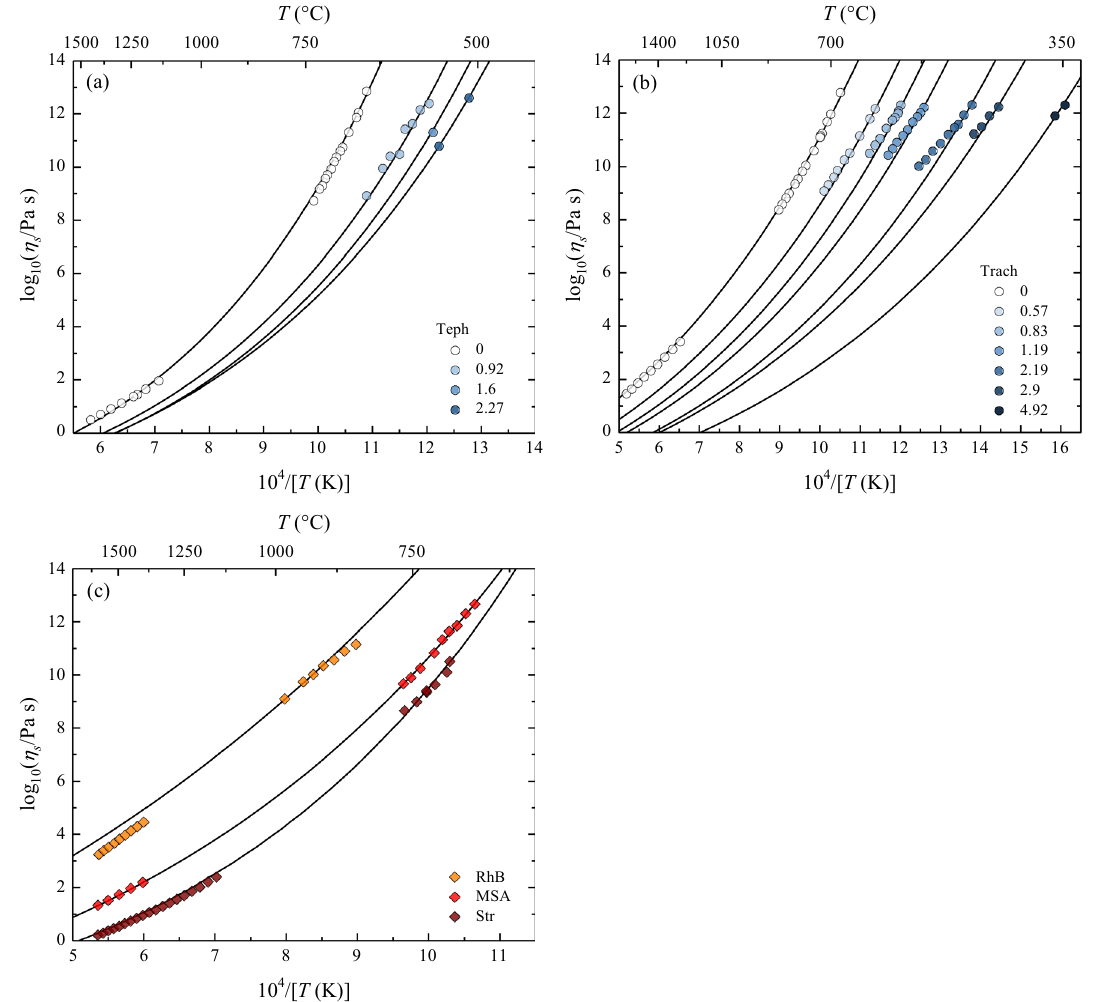
Figure 4. External predictions of anhydrous and hydrous viscosity. ( a ) Measured (symbols) anhydrous and hydrous viscosity data for tephrite (Teph) 61 and predictions (lines) using Brillouin velocities (Table 2). Numbers in the legend indicate the water content of samples in wt%. ( b ) Measured (symbols) anhydrous and hydrous viscosity data for trachyte (Trach) 11 and predictions (lines) using Brillouin sound velocities (Table 2). Numbers in the legend indicate the water content of samples in wt%. ( c ) Measured (symbols) anhydrous viscosity data for the calcalkaline rhyolite RhB 10 , MSA andesite 37,49 and Str basalt 50,51 . Lines are predictions using the boson peak position (Table 2) derived by Raman